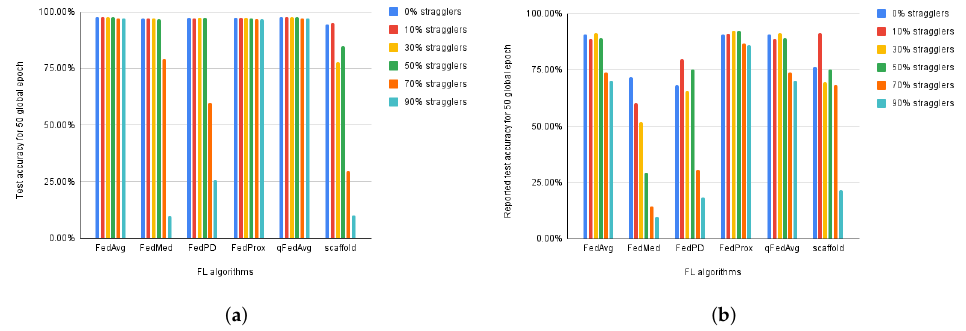
Figure 5. Average accuracy of FL algorithms over ( a ) IID and ( b ) non-IID MNIST data for varying level of